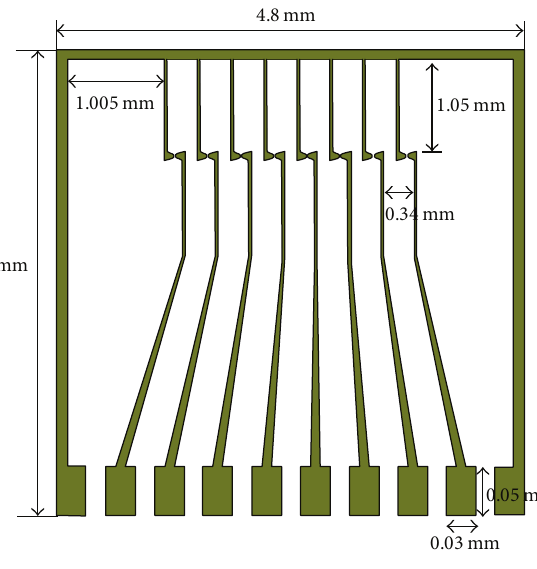
Figure 5: Geometry of the bow-tie element array.